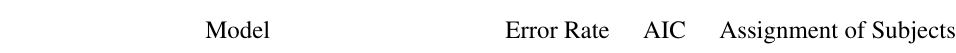
Table 5. Error rates, AIC, and the optimal assignment of subjects in the best models of 1 and 2 decision rules (models with more decision rules have a very negative AIC) for the two subgroups using hypothetical